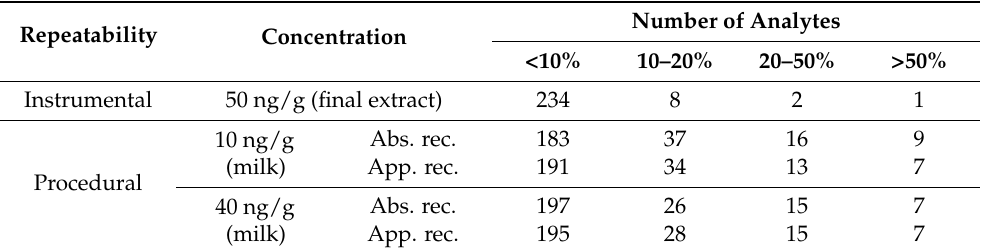
Table 3. Instrumental and procedural repeatability values in terms of RSD (%) for absolute (abs.) and apparent (app.) recoveries at low and high